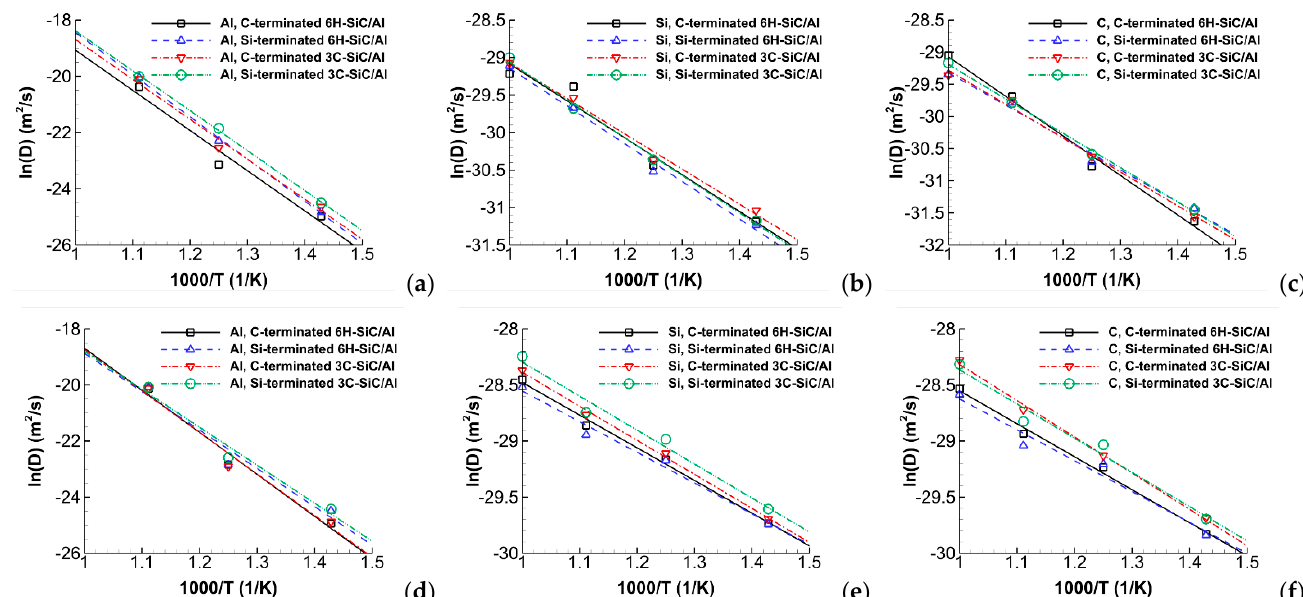
Figure 4. Time histories of the self-diffusion coefficients at different temperatures for different atoms of the ternary SiC/Al diffusion system with 20% vacancy in SiC in the C- and Si-terminated ( a ) 6H- SiC/Al and ( b ) 3C-SiC/Al interfaces.